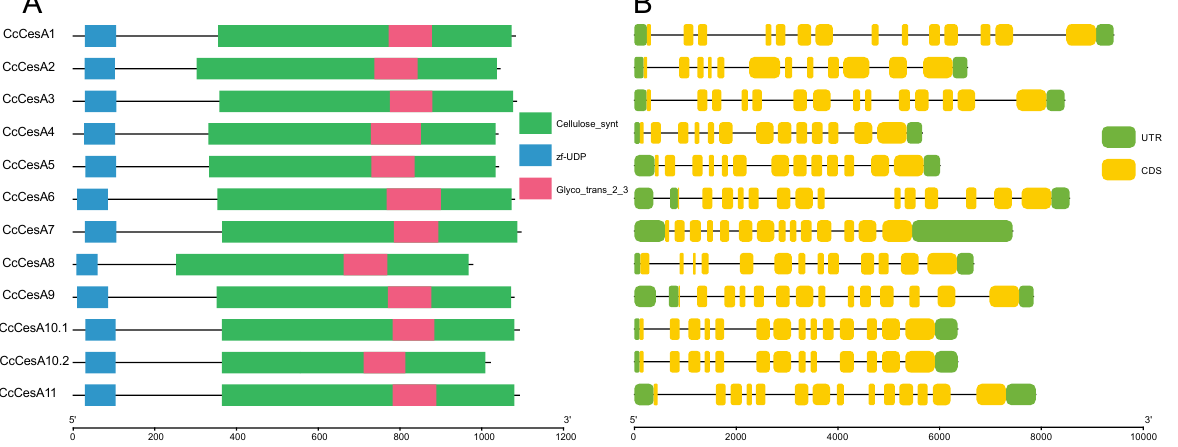
Figure 5. Conserved protein and exon–intron structure of the CcCesA genes. ( A ) Conserved protein structure. The blue boxes represent zf-UDP. The green boxes represent Cellulose_synt. The pink boxes represent Glyco_trans_2_3. ( B ) Exon–intron structures. Yellow boxes indicate exons. Solid lines indicate introns (connecting two exons). Green boxes indicate UTRs.